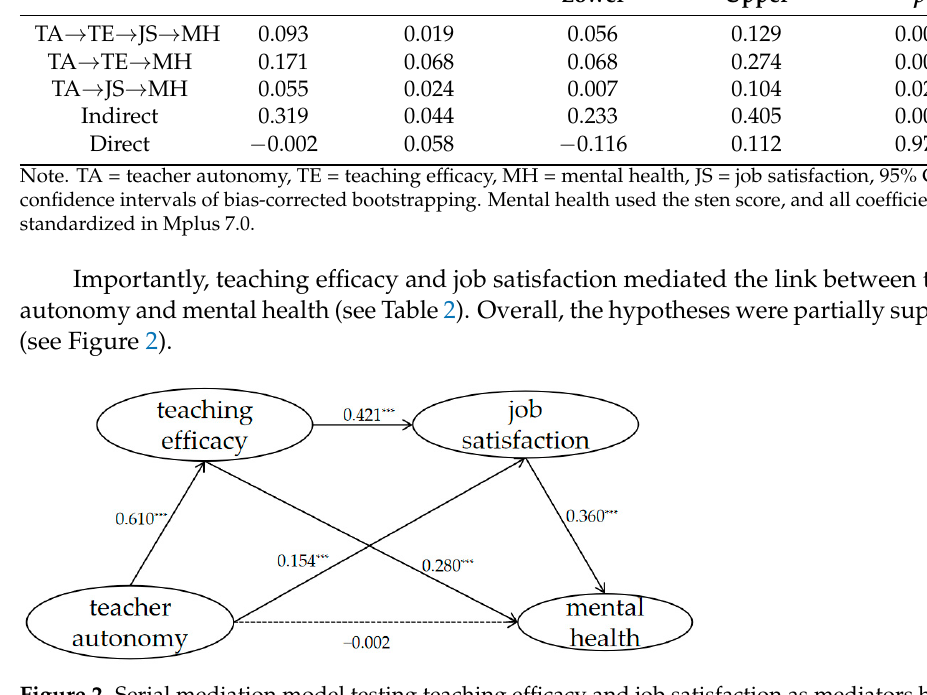
Figure 2. Serial mediation model testing teaching efficacy and job satisfaction as mediators between teacher autonomy and mental health ; *** p <